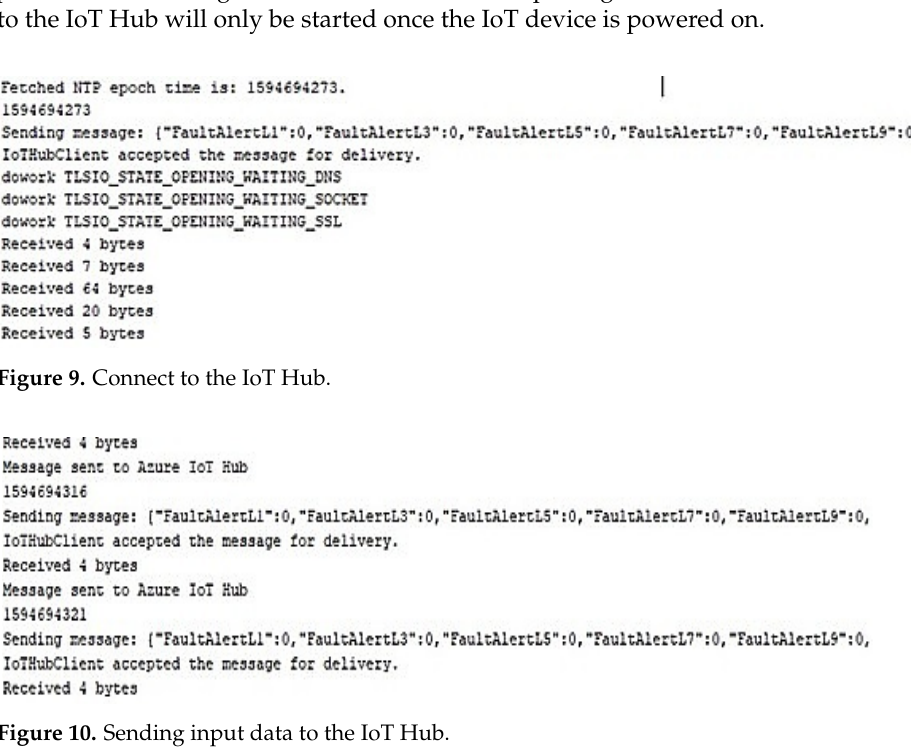
Figure 8. IoT device initiation and Wi-Fi connection.